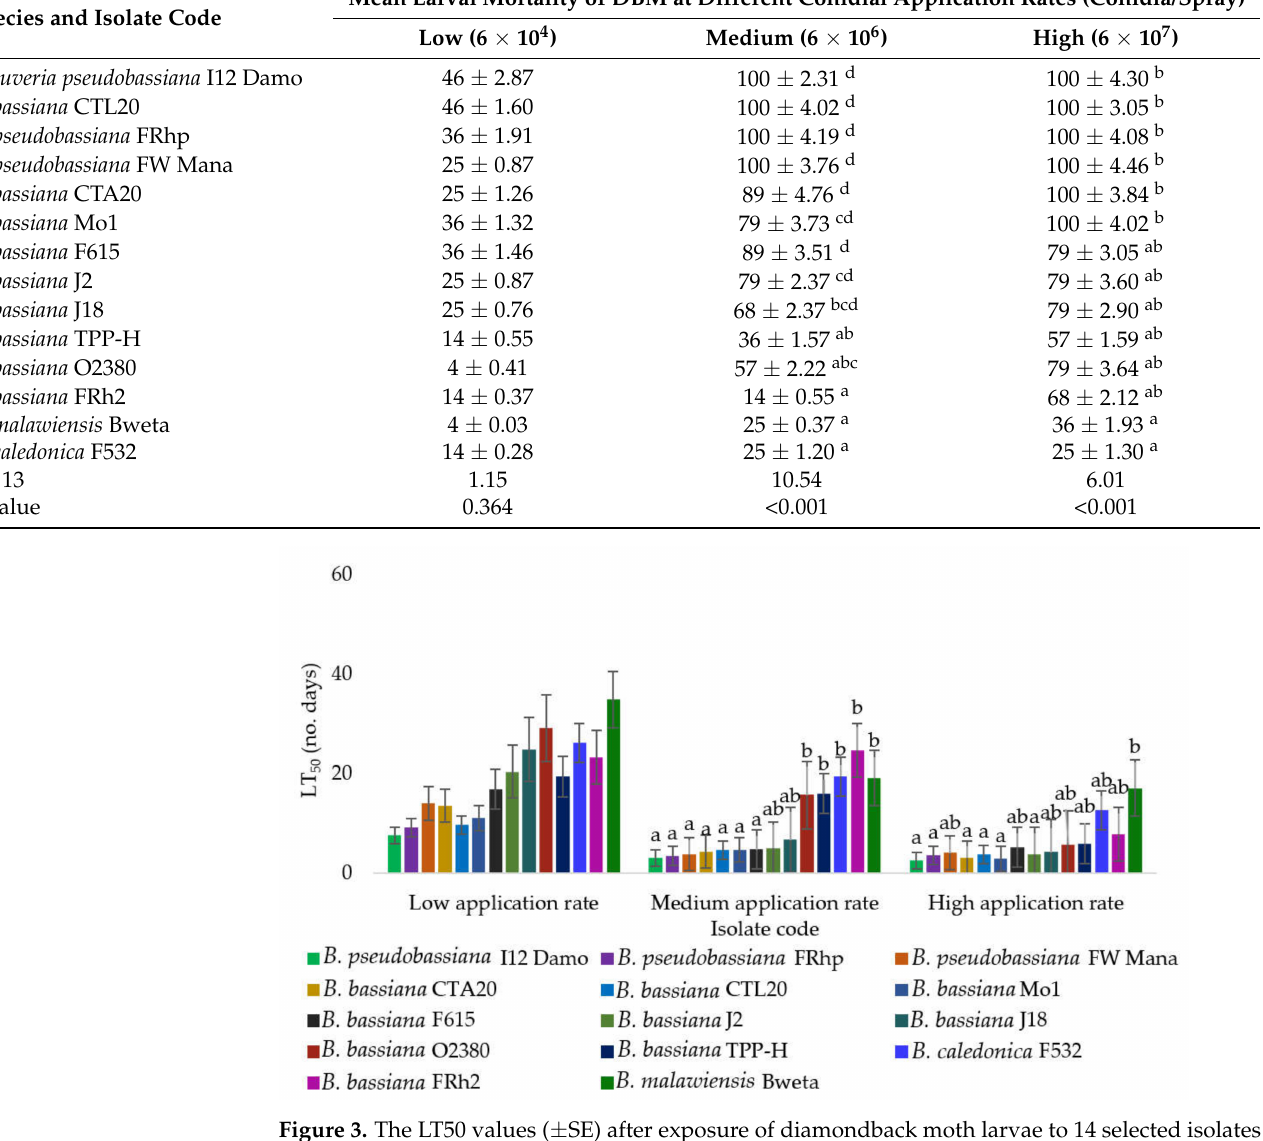
Figure 3. The LT50 values ( ± SE) after exposure of diamondback moth larvae to 14 selected isolates of Beauveria . Bars followed by the same letter are not significantly different according to Tukey’s HSD